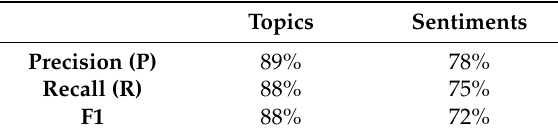
Table 3. Evaluation results of topic